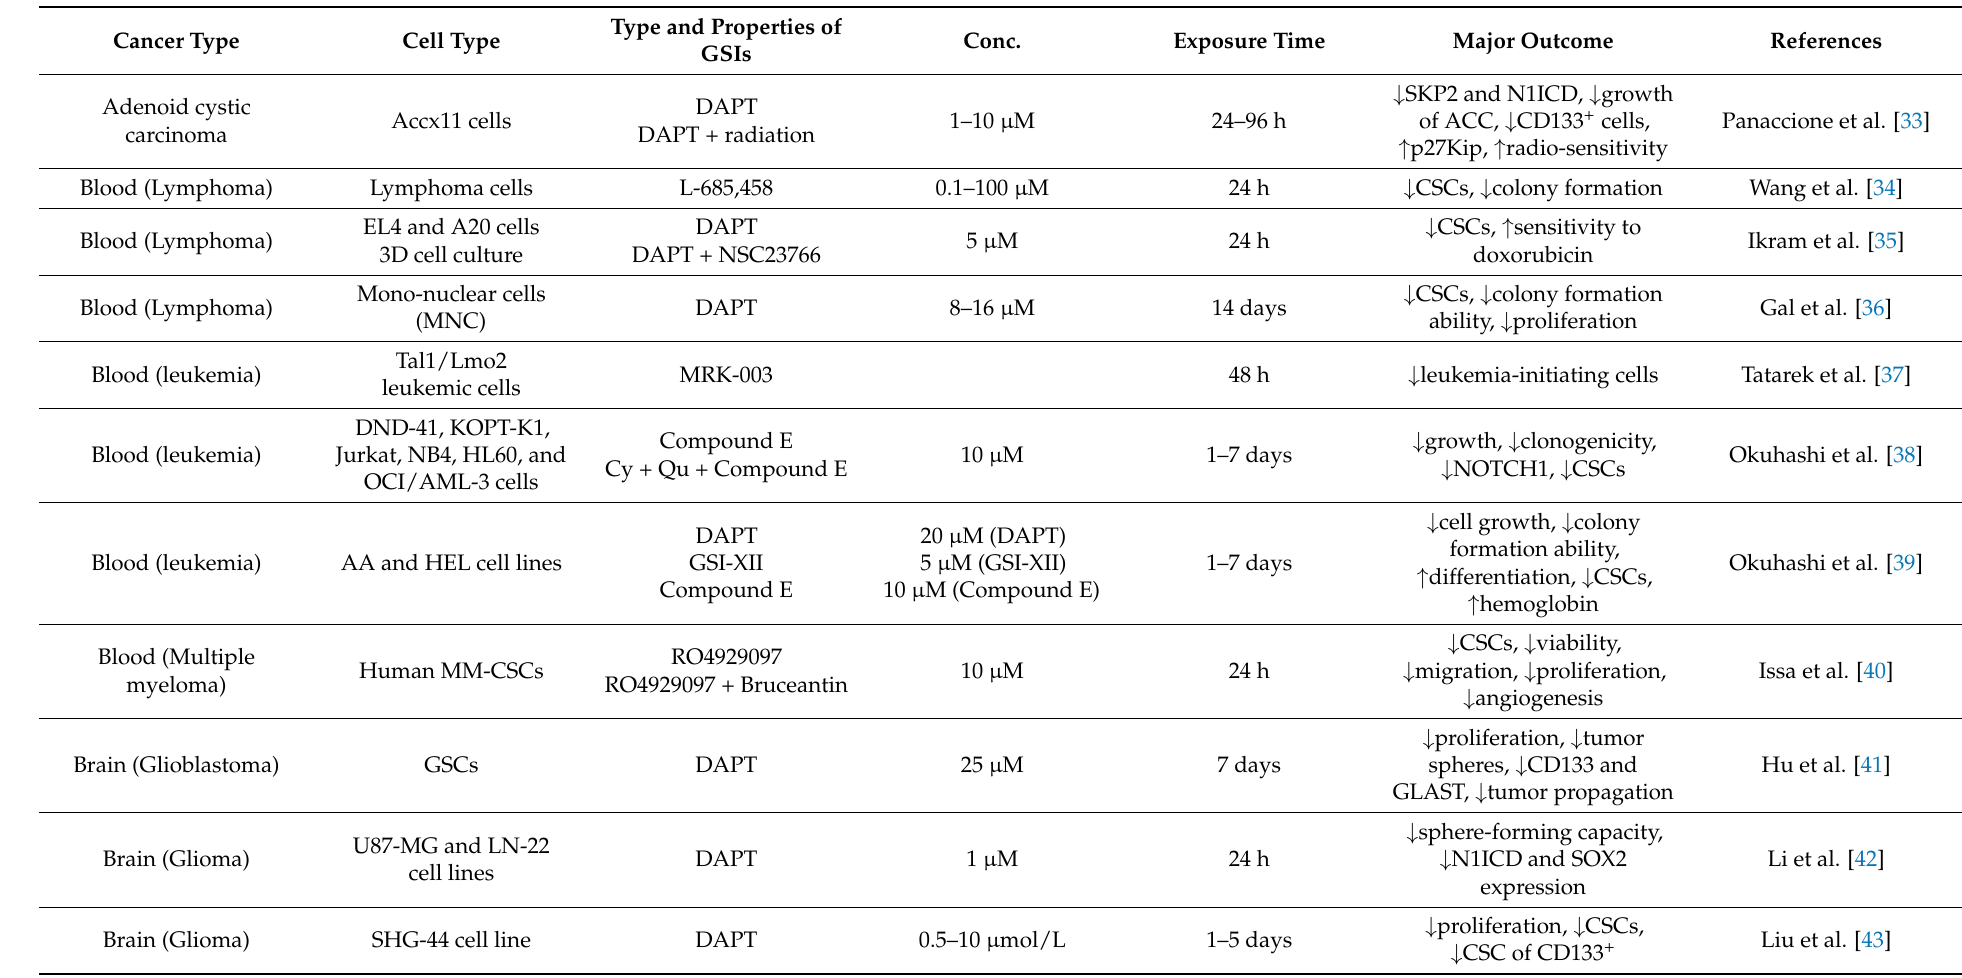
Table 1. Potential anti-cancer stem cell (CSC) effects and related mechanisms of action of γ -secretase inhibitors (GSIs) based on in vitro